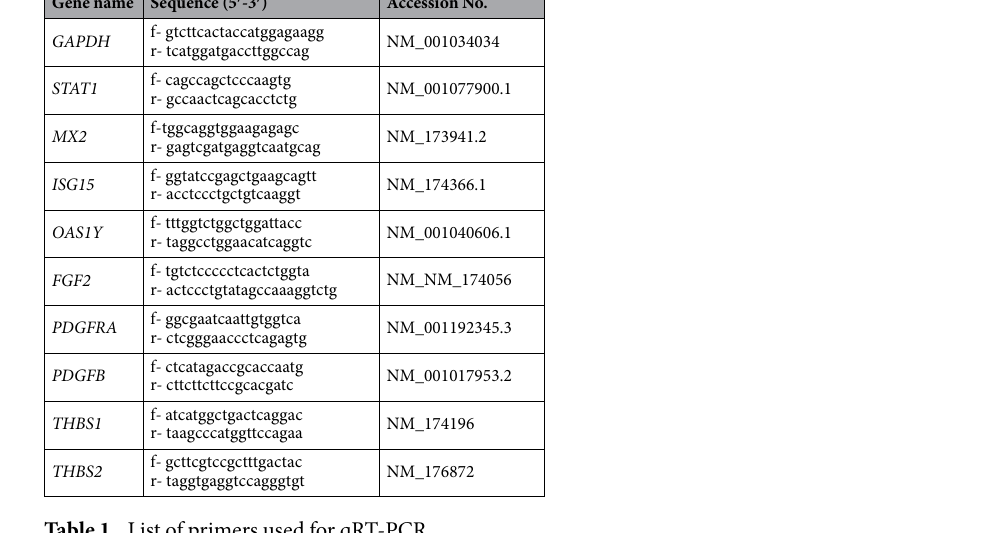
Table 1. List of primers used for